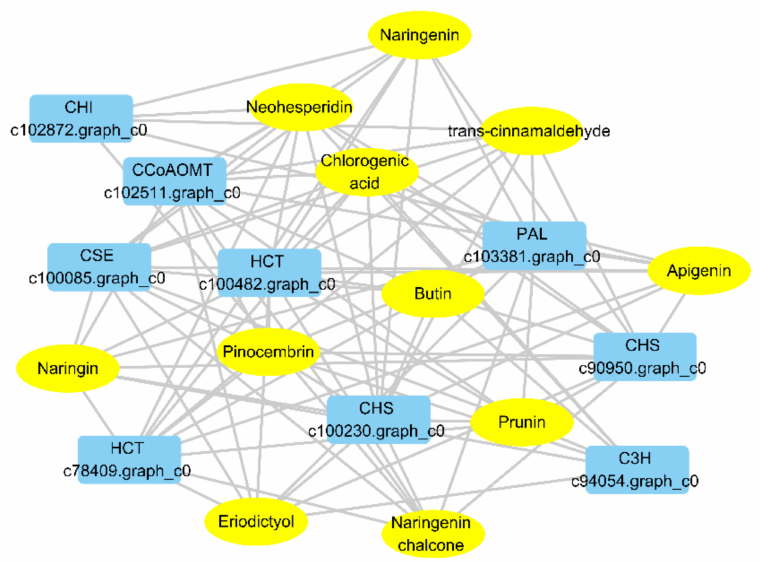
Figure 6. Connection network between differentially accumulated metabolites and related genes in RG. The networks between metabolites and transcripts were visualized with Cytoscape software (version